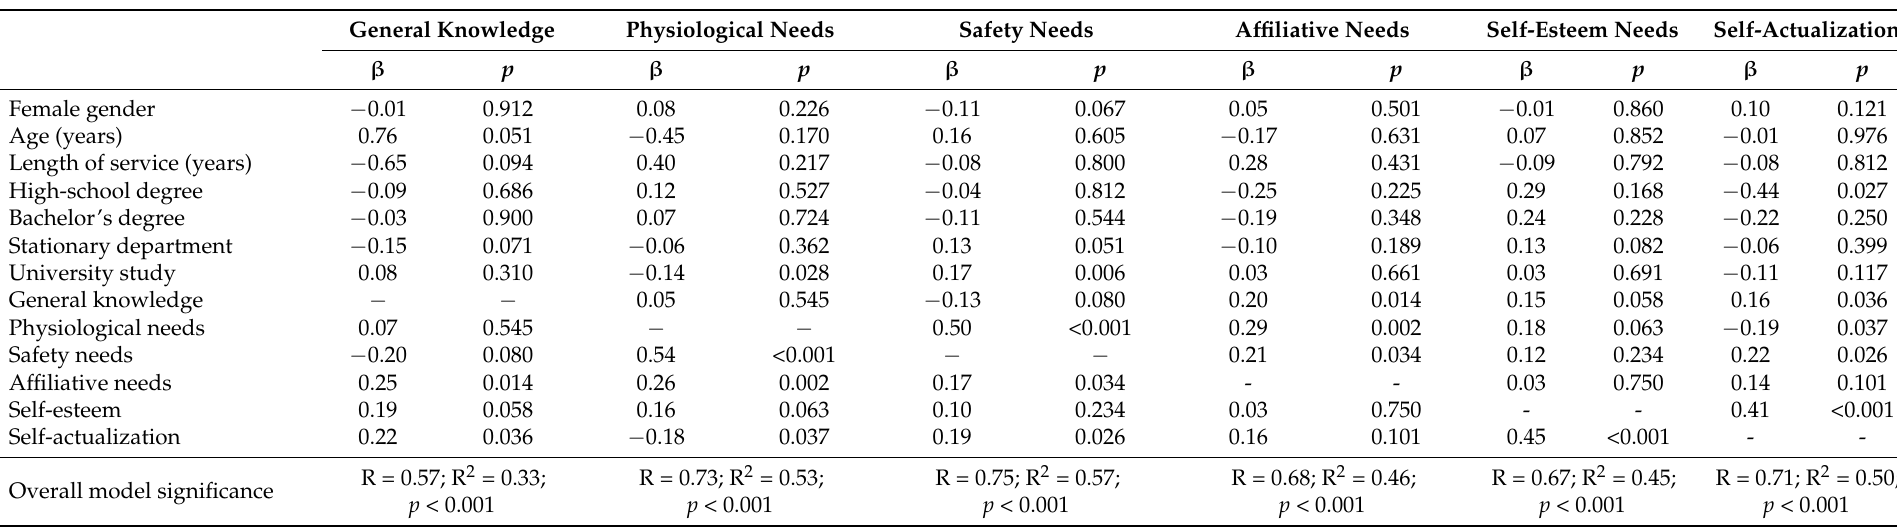
Table 3. Associations between nurses’ sociodemographic characteristics and their knowledge about basic human needs, using linear regression models. General